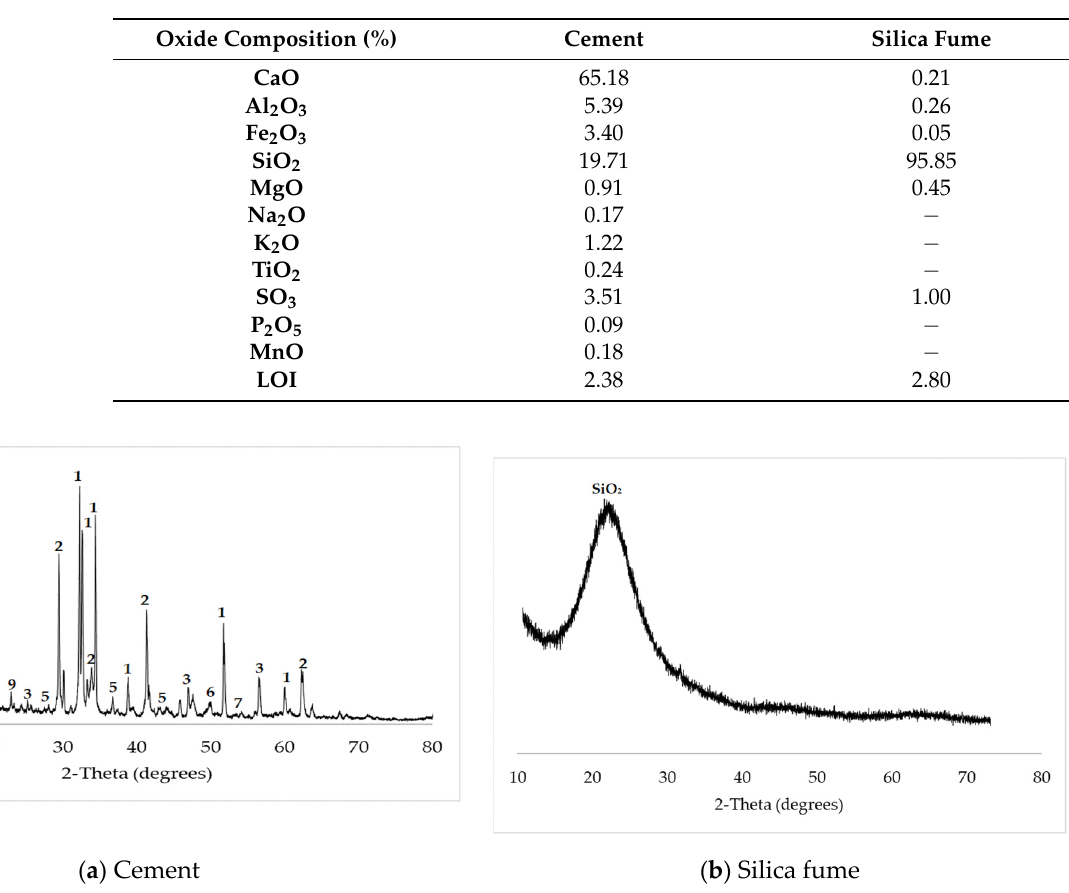
Table 1. Properties of binder materials.